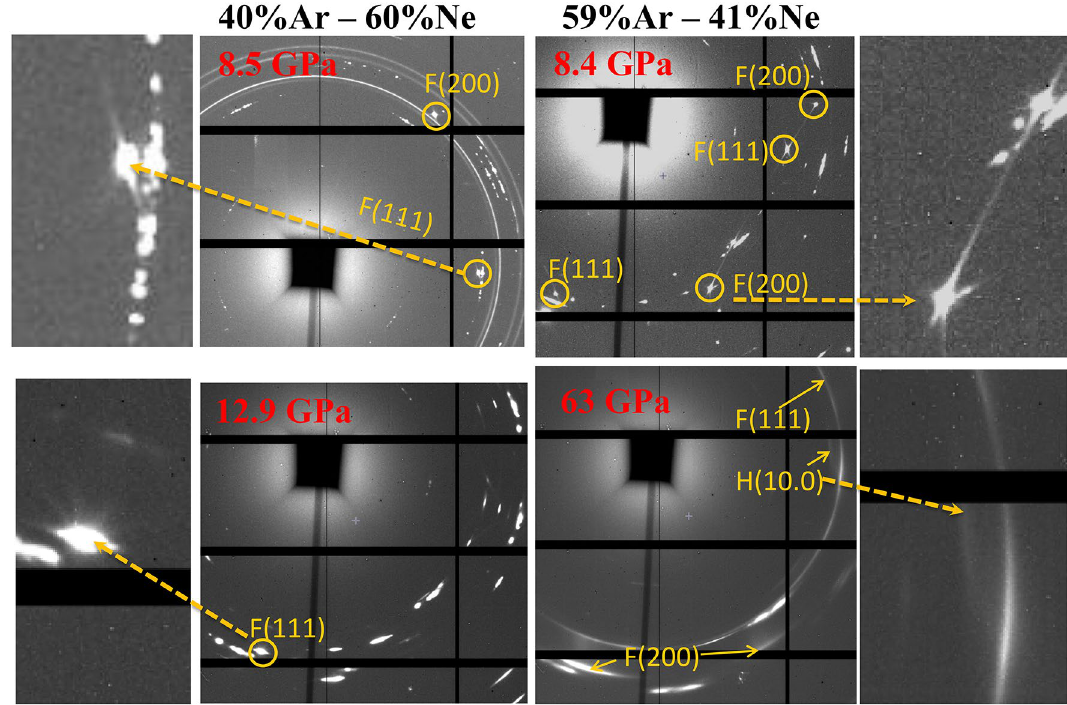
Figure 3. Textures in Ar-Ne mixtures (runs 2–3). Portions of bidimensional X-ray diffraction patterns collected in Ar–Ne mixtures (uppper left corner: run 3; others: run 2). The square shadow of the beamstop marks the position of pattern center. Ar XRD peaks are labelled in yellow. The remaining peaks correspond to ArNe 2 for run 2, and ArNe 2 and gold (continuous ring) for run 3. Evidence of non-hydrostatic compression—a broadening of Ar single crystal XRD peaks—appears above 10 GPa in run 2. Around 8.5 GPa, stacking faults create a structured diffuse signal around single crystal Ar XRD spots for both samples, which clearly appears in the enlarged pictures. This signal progressively transforms into (100) (labelled H(10.0)) hcp XRD